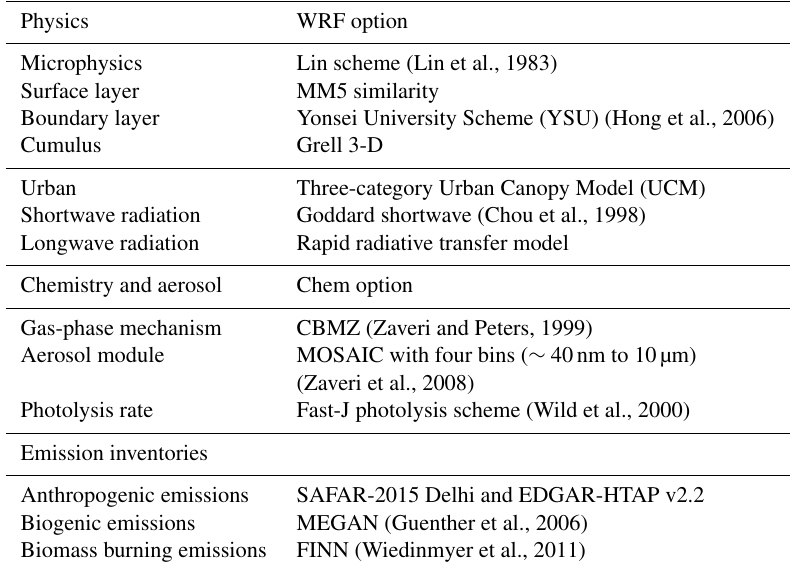
Table 1. Configuration of WRF-Chem. Physics WRF option Microphysics Lin scheme (Lin et al., 1983) Surface layer MM5 similarity Boundary layer Yonsei University Scheme (YSU) (Hong et al., 2006) Cumulus Grell 3-D Urban Three-category Urban Canopy Model (UCM) Shortwave radiation Goddard shortwave (Chou et al., 1998) Longwave radiation Rapid radiative transfer model Chemistry and aerosol Chem option Gas-phase mechanism CBMZ (Zaveri and Peters, 1999) Aerosol module MOSAIC with four bins ( ∼ 40nm to 10µm) (Zaveri et al., 2008) Photolysis rate Fast-J photolysis scheme (Wild et al., 2000) Emission inventories Anthropogenic emissions SAFAR-2015 Delhi and EDGAR-HTAP v2.2 Biogenic emissions MEGAN (Guenther et al., 2006) Biomass burning emissions FINN (Wiedinmyer et al.,